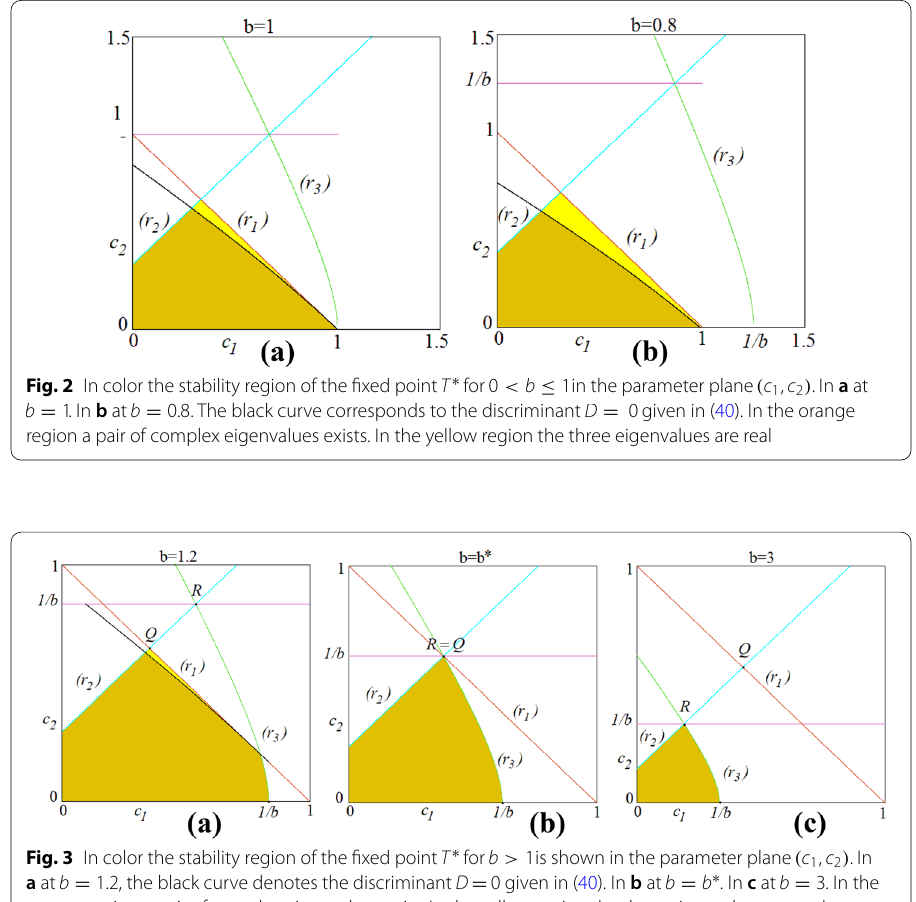
3 . In the b ∗ . In c at b 0 given in (40). In b at b = = =